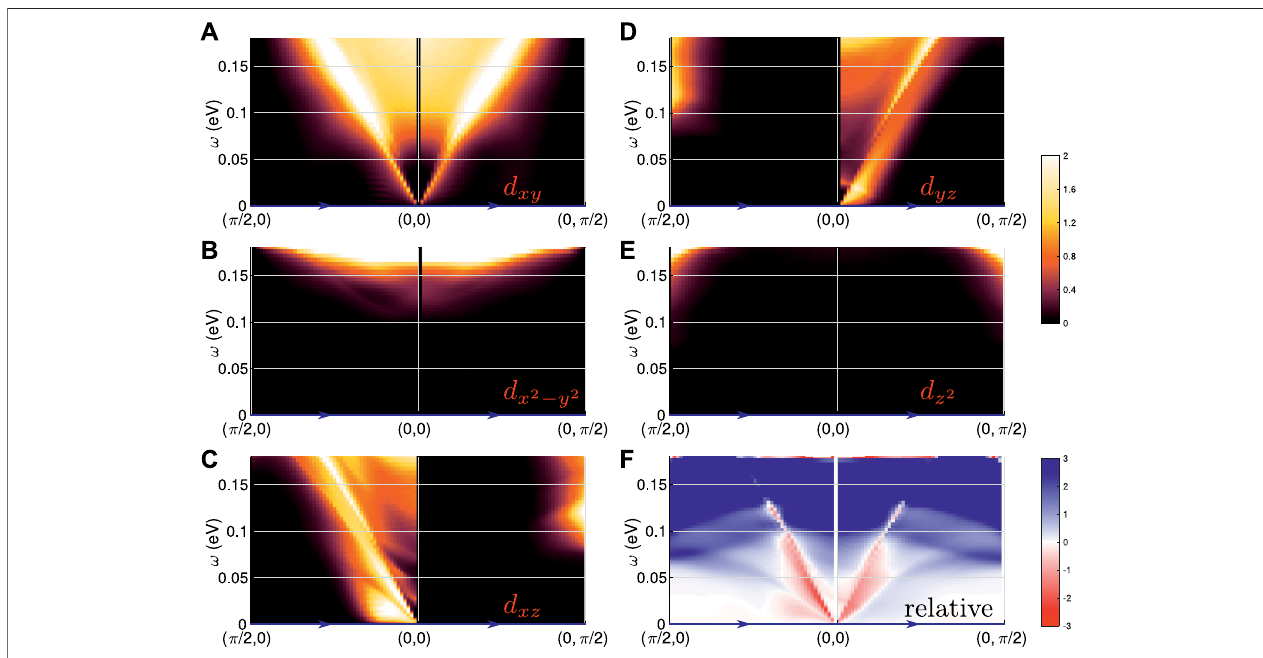
FIGURE 6 | RIXS intensity from single orbital components. Intensity calculated by setting Z l = 0, except for one orbital component, where Z l * (cid:1) 1 (A – E) , i.e., in the sum in Eq. 8 only the fully diagonal components of the susceptibility contribute. The off-diagonal contributions are sizeable as showin in panel (F) where the results of panels (A – E) multiplied by the number of orbitals are subtracted from the full RIXS intensity as shown in Figure 5A